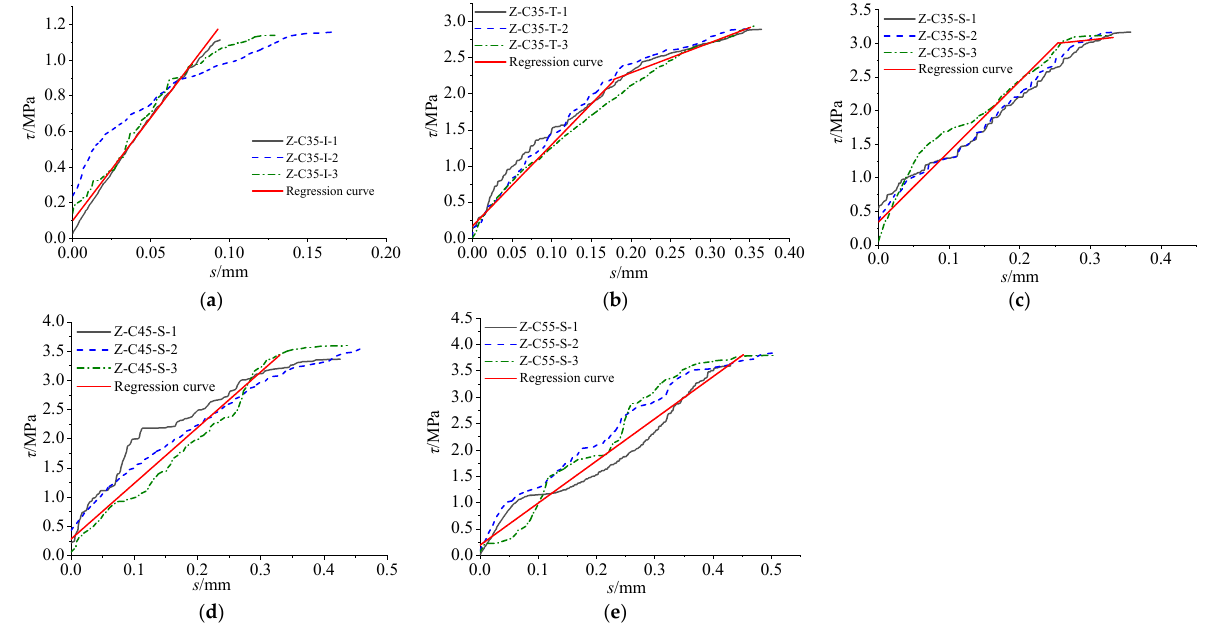
Figure 8. Bond stress–slip curves of direct shear specimens: ( a ) Z-C35-I; ( b ) Z-C35-T; ( c ) Z-C35-S; ( d ) Z-C45-S; ( e ) Z-C55-S.